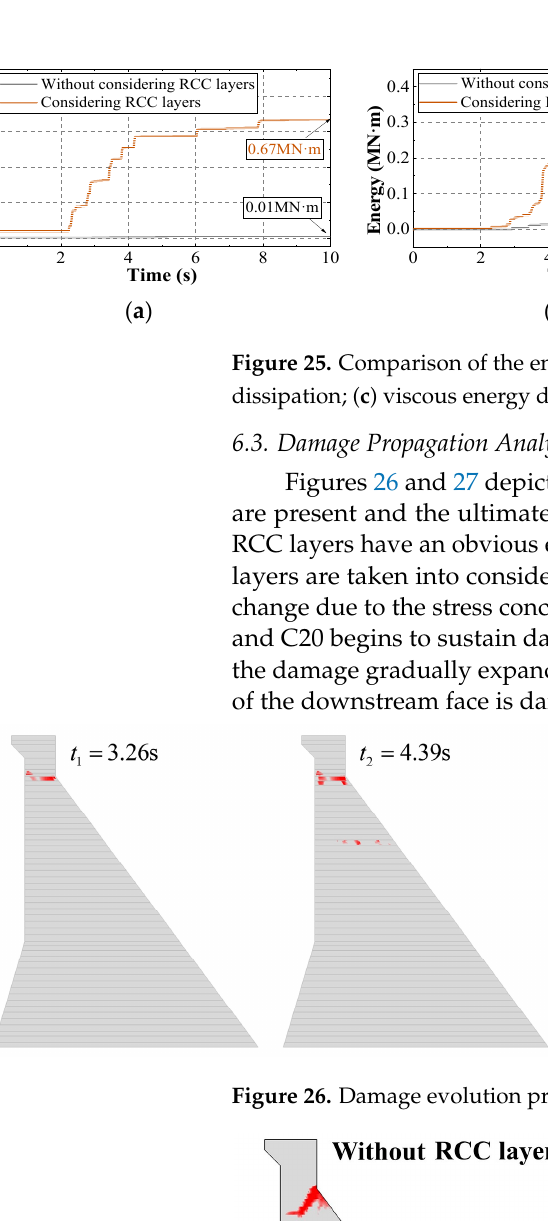
( b ) Figure 24. Stress time histories near the change in downstream slope. ( a ) Maximum principal stress; ( b ) minimum principal stress. The energy dissipation of the two situations is also compared herein. Similarly, the energy dissipation of the dam during the strong earthquake is dominated by the damping dissipation mechanism. Figure 25 illustrates how the energy dissipation of the RCC dam differs dramatically from the normal concrete dam. The viscous energy dissipation with RCC layers is about twice that of the dam without RCC layers, whose increase range is smaller than that of the plastic and damage-induced energy dissipation. The damaged-